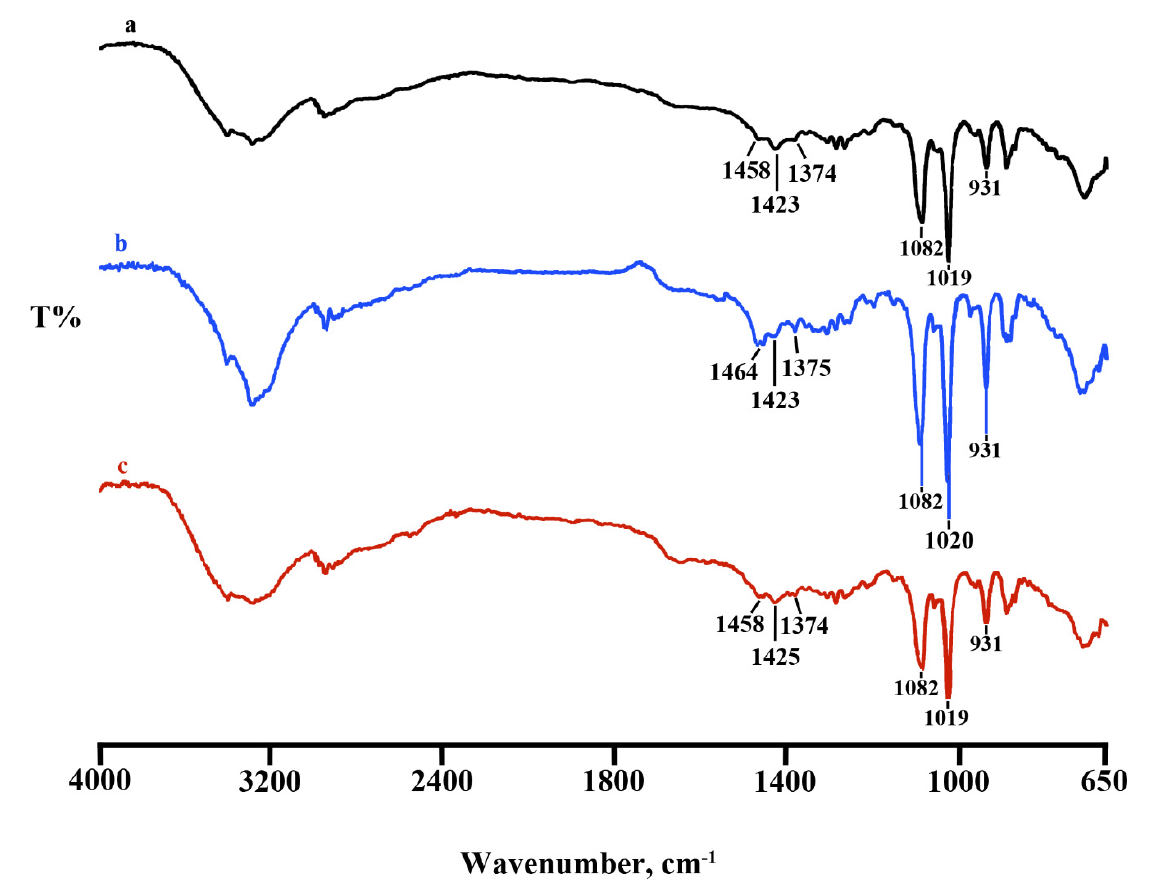
Figure 1. Comparison between FTIR spectra of Lyosecretome batch 1 (spectrum a), 2 (spectrum b), and 3 (spectrum c), respectively.